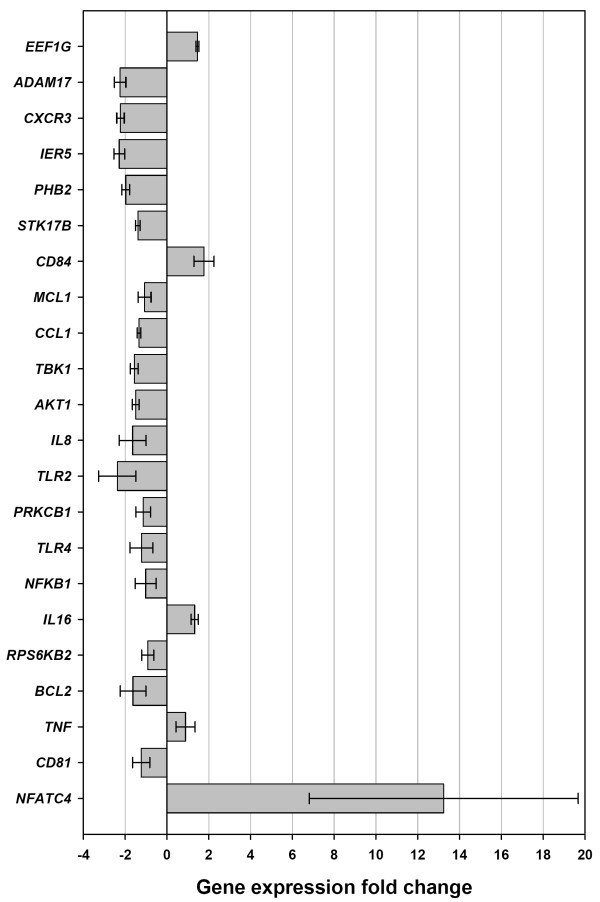
Genes chosen for real time qRT-PCR data validation. Shown are relative levels of differential gene expression confirmed between treatment groups ex vivo using real time qRT-PCR. Fold change values are shown for PBMC from BTB-infected cattle (n = 8) relative to PBMC from healthy control animals (n = 8). Error bars show the standard error of the mean for each gene.